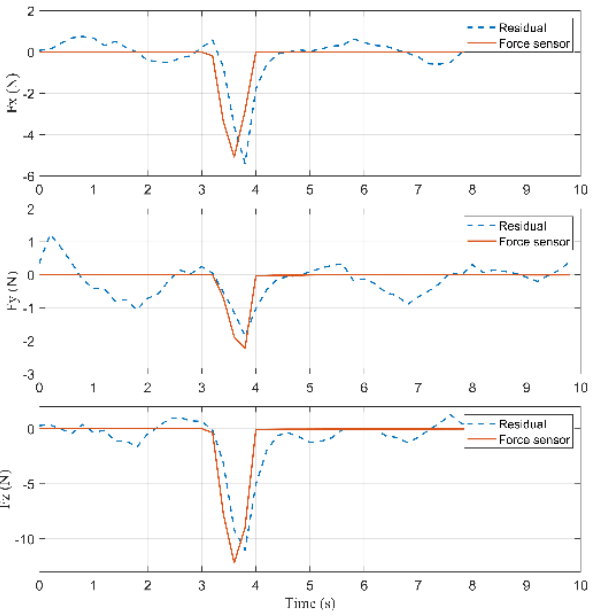
Figure 11. Comparison of the residuals for the force sensor in Case 1.